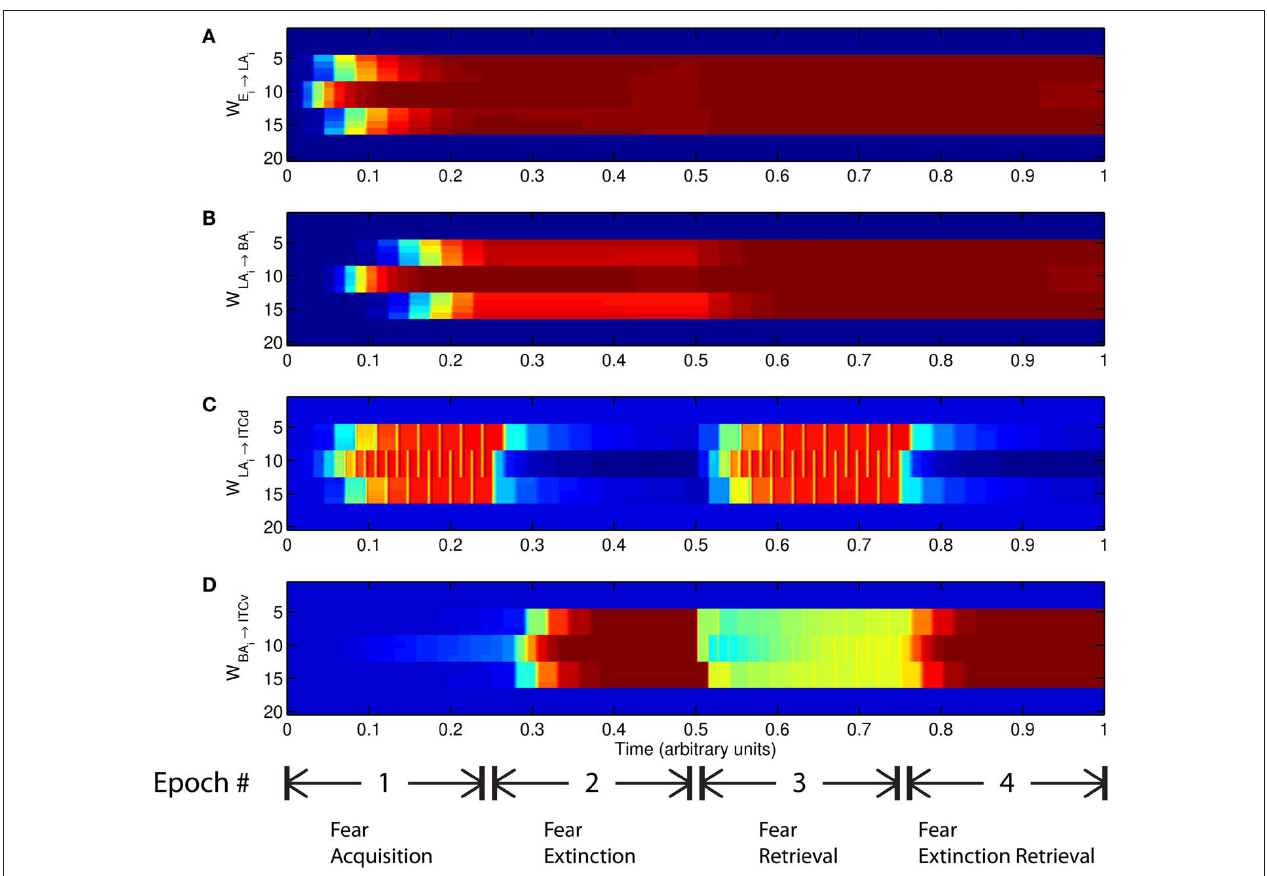
FIGURE 6 | Time evolution of model synaptic weights during “normal” mode. The system exhibits fear acquisition, extinction, fear retrieval, and extinction retrieval. Plots show the time evolution of model connection weights during four consecutive epochs. Each plot (A–D) shows the temporal evolution of an array of 20 connection weights, with the y-axis representing